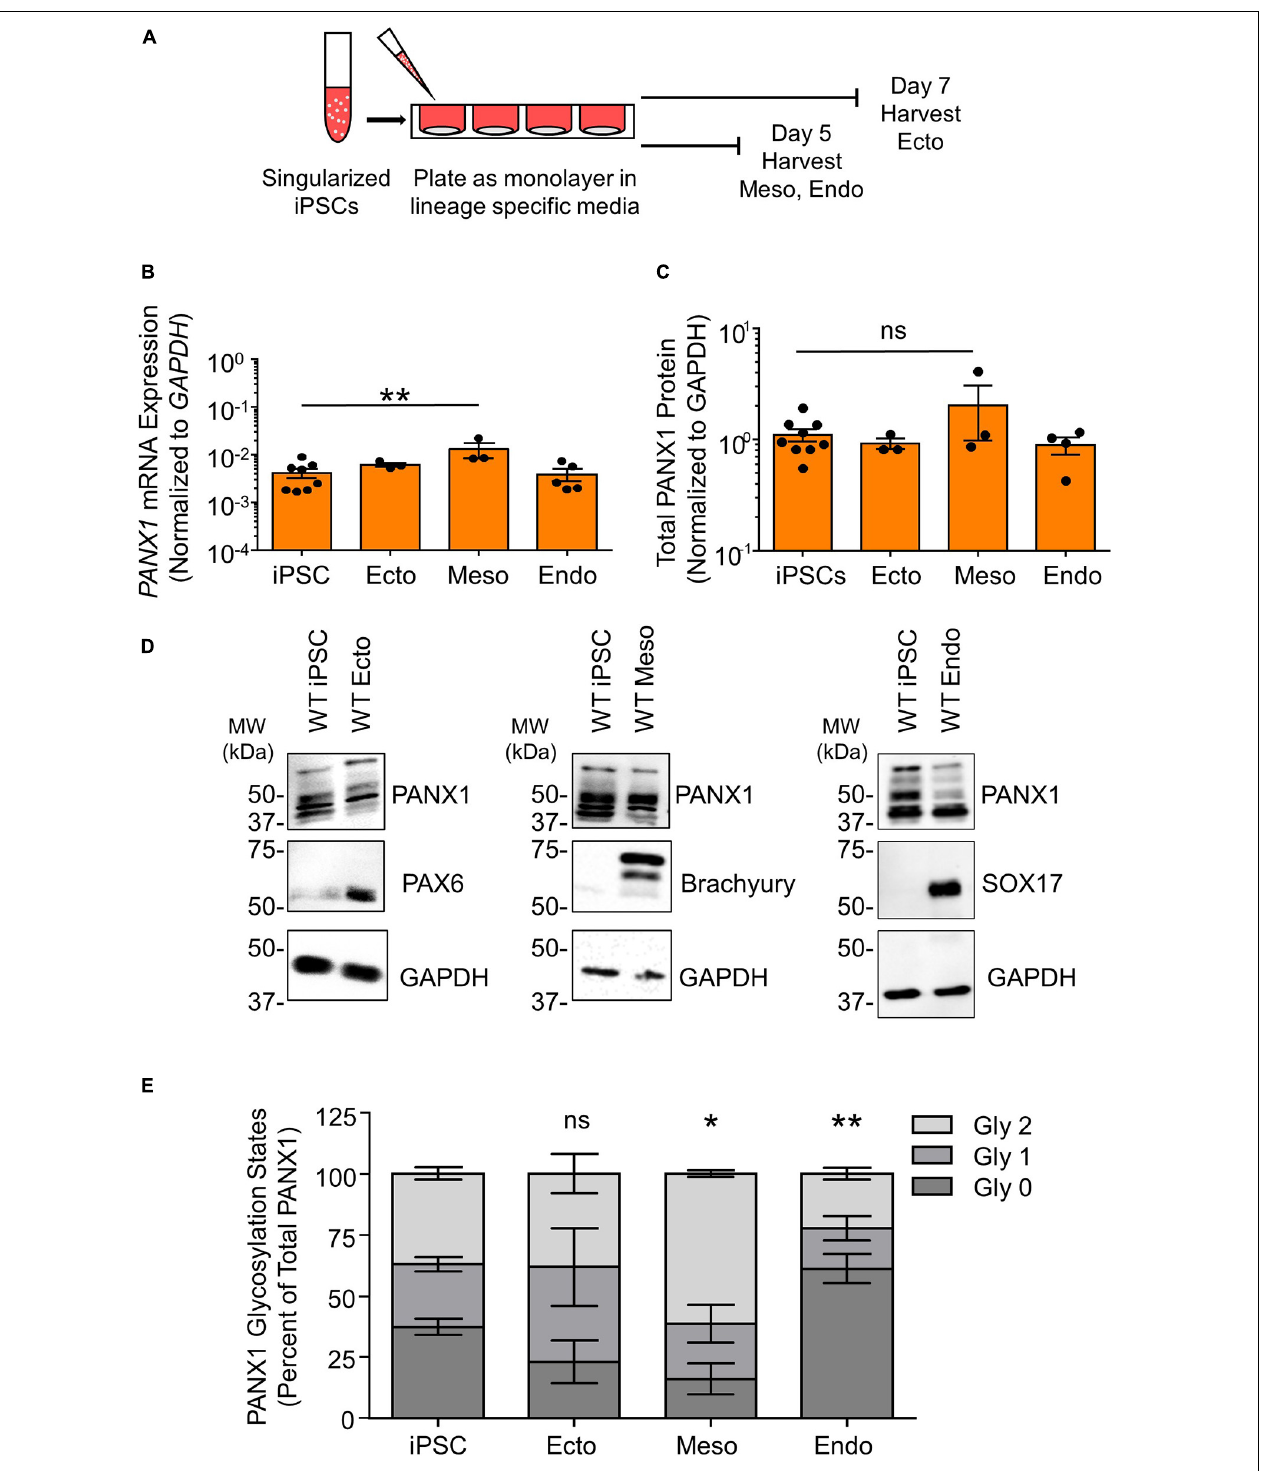
FIGURE 3 | PANX1 is expressed in cells from all three embryonic germ layers. (A) Schematic depicting 2D directed germ lineage differentiation. (B) qPCR analysis of PANX1 mRNA expression in control human iPSCs as well as after directed differentiation into each of the three embryonic germ layers, ectoderm (ecto), mesoderm (meso), and endoderm (endo). (C) Densitometric analysis of total PANX1 protein expression in iPSCs, ectoderm, mesoderm, and endoderm cells. (D) Representative Western blots and (E) densitometric analysis of the three PANX1 glycosylation states. Gly0, non-glycosylated protein; Gly1, high mannose; Gly2, complex carbohydrate addition. Data represent the standard error of the mean of 3-10 independent experiments. ns, no significance; *, p < 0.05; **, p < 0.01 compared to iPSCs.